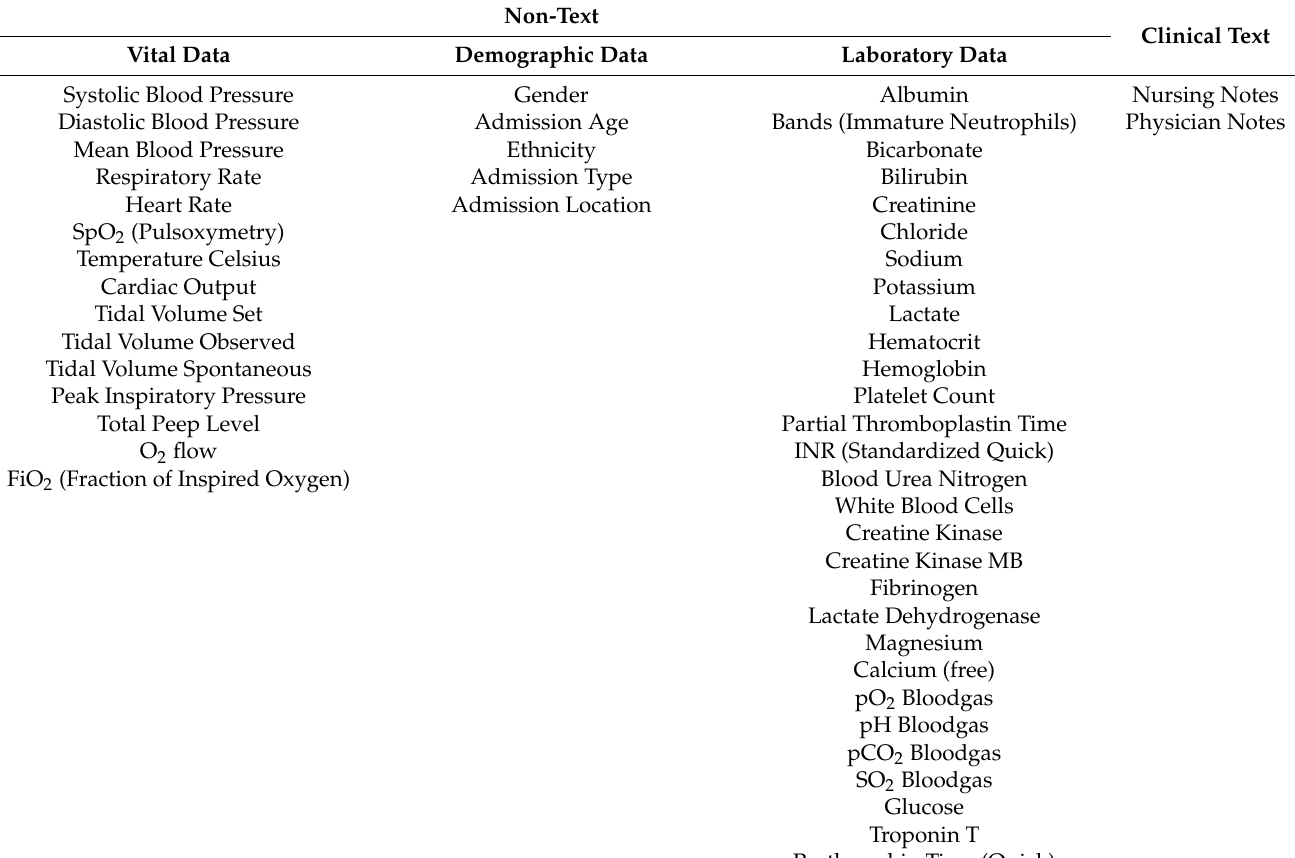
Table 1. List of the data features.